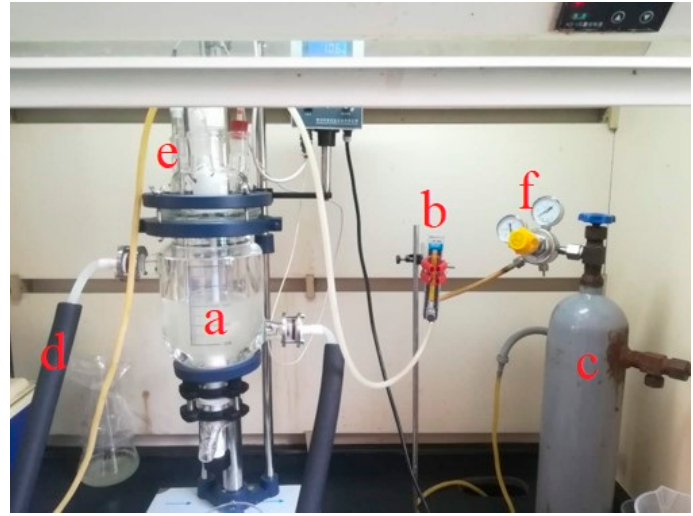
Figure 1. Diagram of crystallization system (a—reactor, b—flowmeter, c—gas cylinder, d—thermostatic water-circulating bath, e—thermometer, f—relief valve).